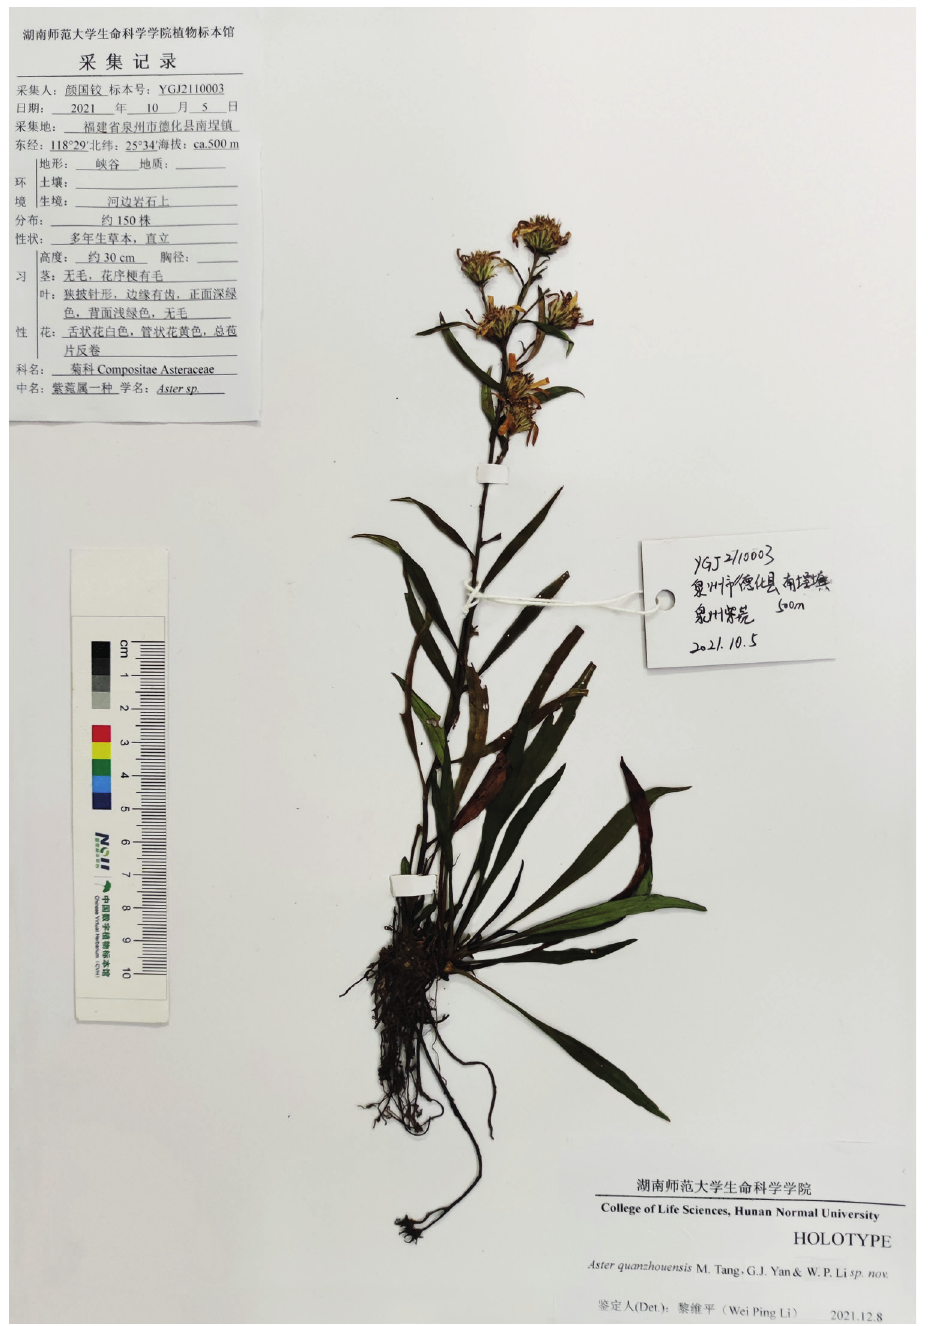
Figure 3. Holotype of Aster quanzhouensis M.Tang, G.J.Yan &